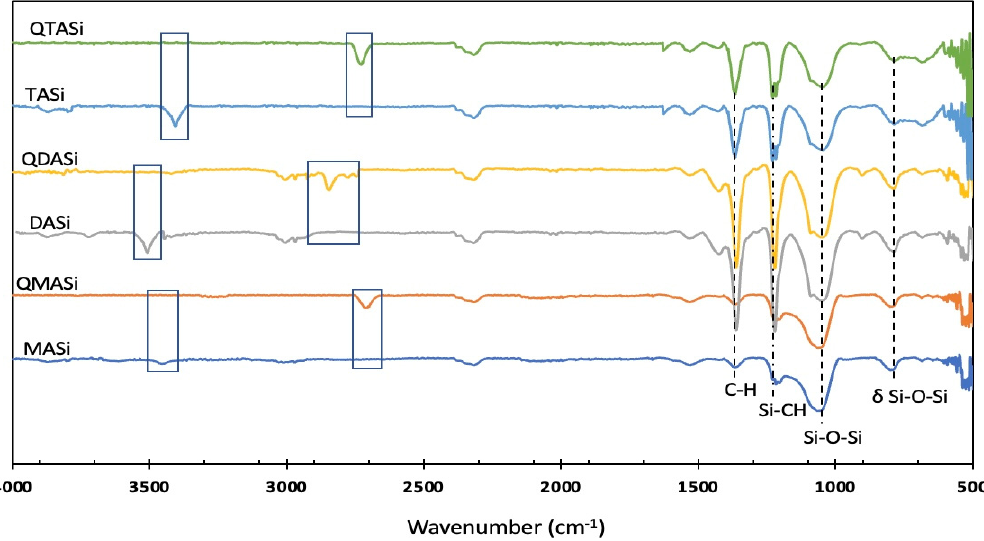
Figure 1. FTIR spectra of amine-functionalized silica gel and their quaternary salts (QTASi, TASi, QDASi, DASi, QMASi, and MASi).